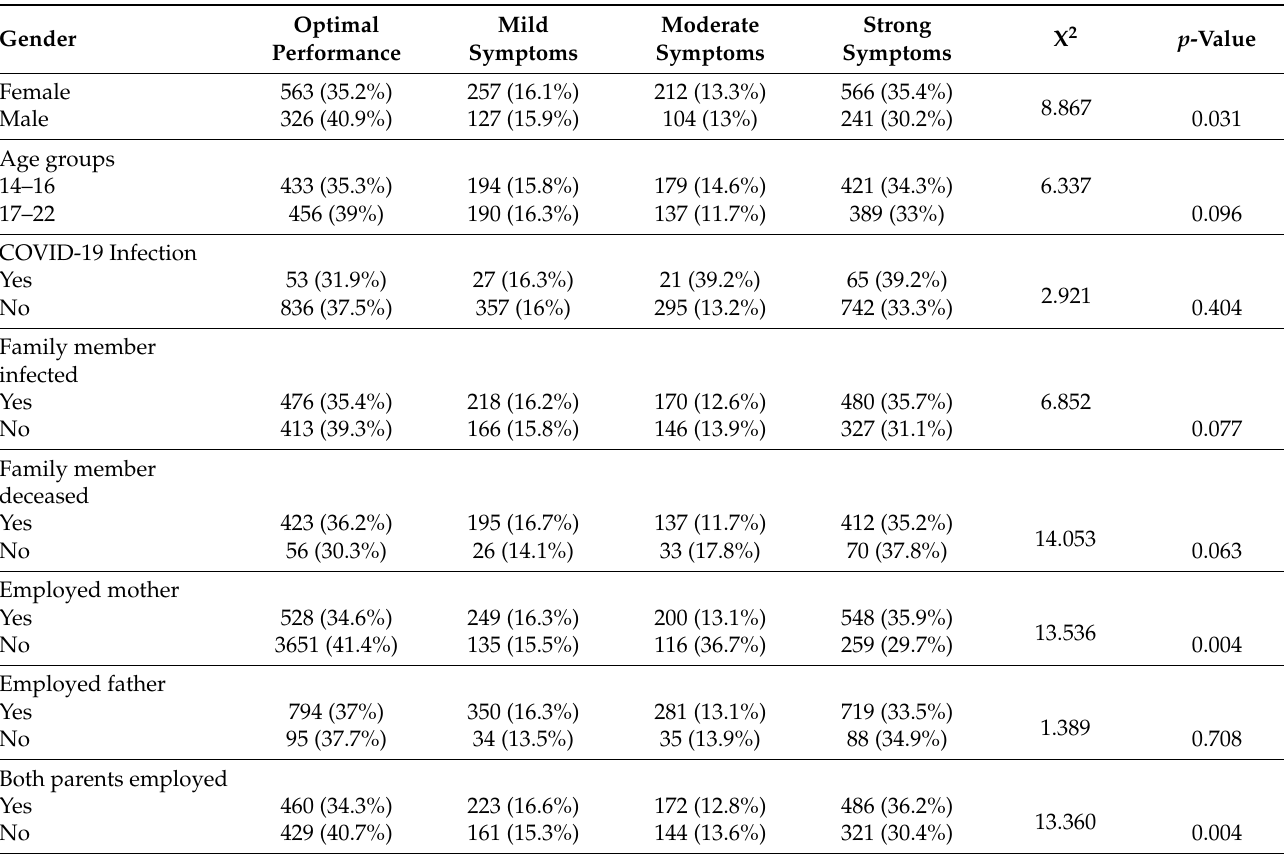
Table 3. DEX-Sp Classification scores distribution between